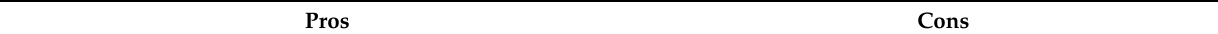
Table 3. Advantages and disadvantages of antibody-based drugs in cerebral